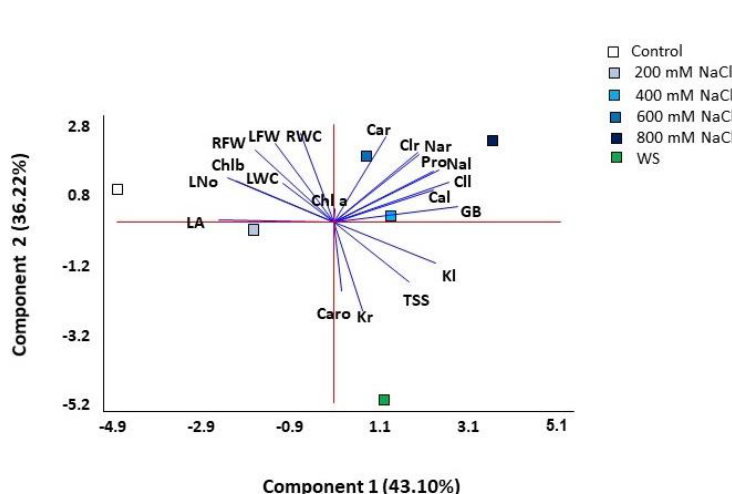
Figure 8. Biplot of the principal component analysis (PCA) conducted with the analysed traits in Limonium angustebracteatum plants subjected to one-month stress treatments. Abbreviations: LNo, number of leaves; LA, leaf area; RFW, root fresh weight; LFW, leaf fresh weight; RWC, root water content; LWC, leaf water content; Chla, chlorophyll a; Chl b, chlorophyll b; Caro, carotenoids; Na +r, sodium in roots; Na +l sodium in leaves; Cl −r , chlorine in roots; Cl −l , chlorine in leaves; K +r , potassium in roots; K +l , potassium in leaves; Ca 2+r , calcium in roots; Ca 2+l , calcium in leaves; Pro, proline; GB, glycine betaine; TSS, total soluble sugars.